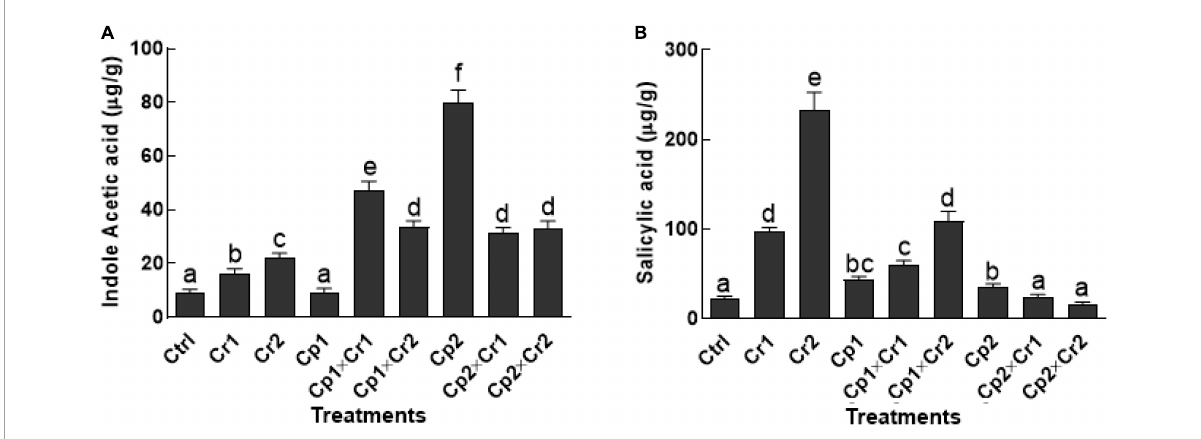
FIGURE3 (A) Indole-3-acetic acid (IAA); (B) Salicylic acid of 15-days-old soybean plants after treatment with endophytes Cp1 and Cp2 exposed to chromate stress. Cp1 = Stemphylium lycopersici ; Cp2 = Stemphylium solani ; Ctrl = control; Cr1 = 10 ppm chromium; Cr2 = 50 ppm chromium. Each bar represents mean of triplicated data ( n = 3) with standard error. Bars that are labeled with different letters are significantly different at p < 0.05 computed by Duncan multiple range test.